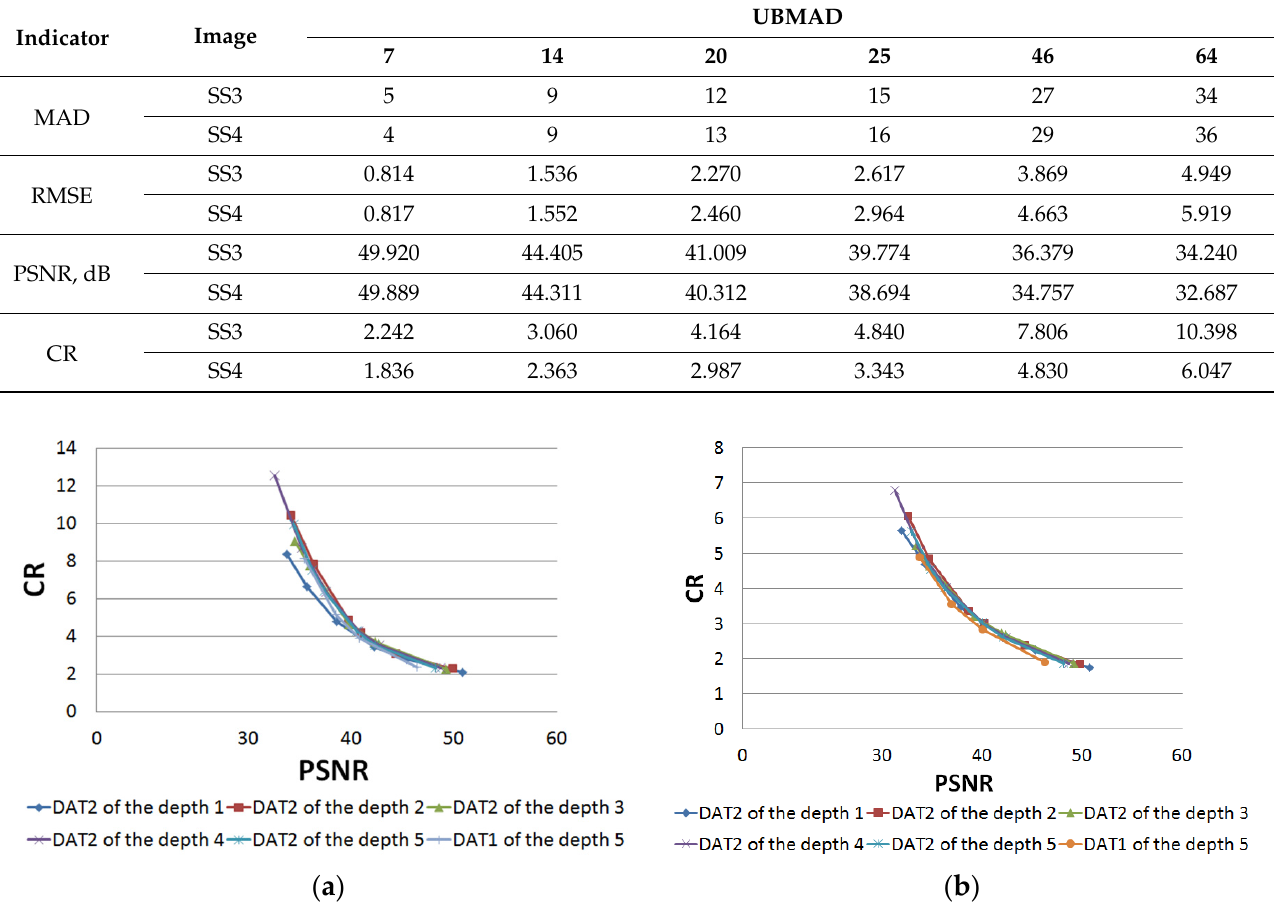
Figure 13. Processing of the test images SS3 ( a ) and SS4 ( b ): dependence of CR on PSNR. Table 4. Results of compressing SS3 and SS4 using DAC with DAT1 of the depth 5.